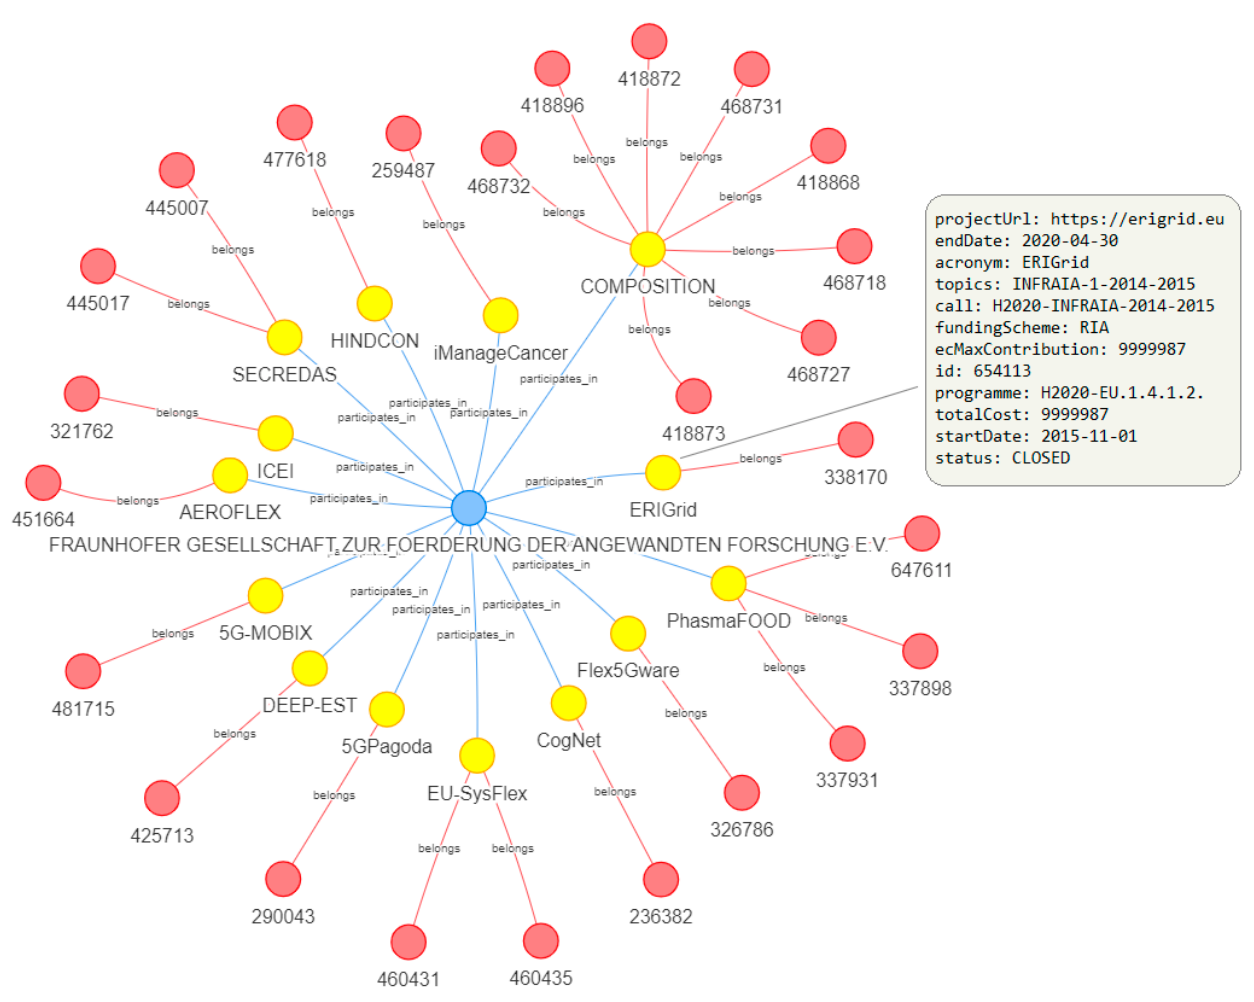
Figure 5. Visualization of a specific organization and some of its projects and respective deliverables.